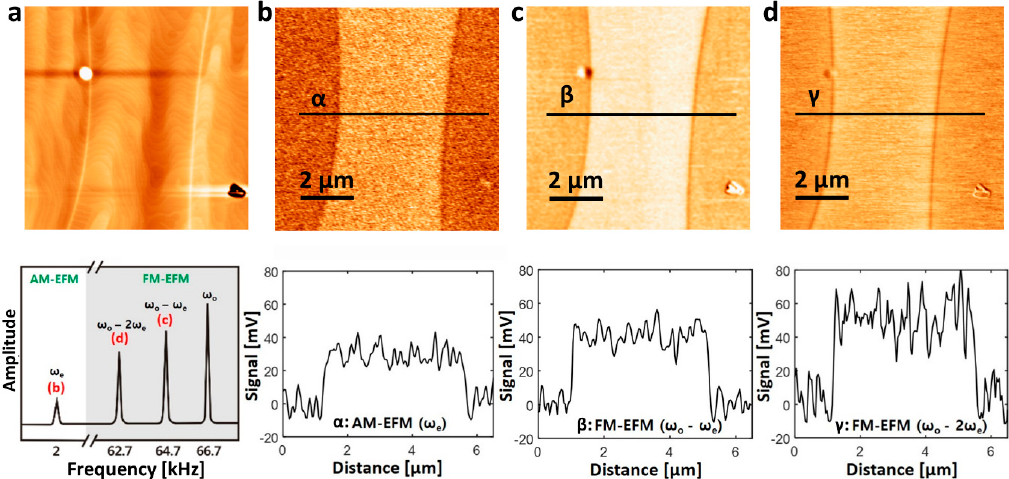
Figure 3. Applied optimal frequency using EFM set-up. Images of triglycine surface (TGS) in 10 μ m × 10 μ m scan size. ( a ) The topographic image; ( b ) AM mode image and line profile ( ω e : 2 kHz, SNR: 6.5735); ( c ) FM–EFM image and line profile ( ω o − ω e : 64.7 kHz, SNR: 8.8943); ( d ) FM–EFM image and line profile ( ω o − 2 ω e : 62.7 kHz, SNR: 5.1456); FM: frequency modulation; AM: amplitude modulation.